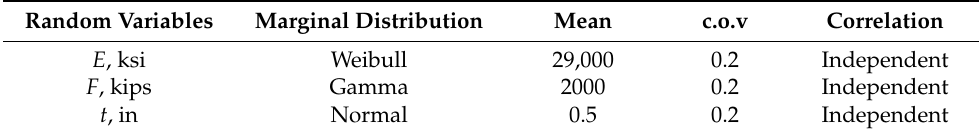
Table 6. Description of the random variables for the cantilever beam problem.